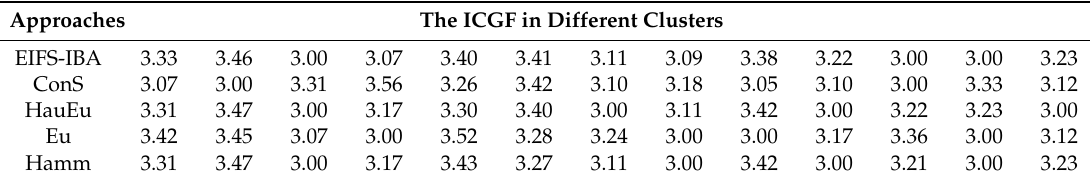
Table 7. The information content of geometric features (ICGF) in different clusters by different similarity